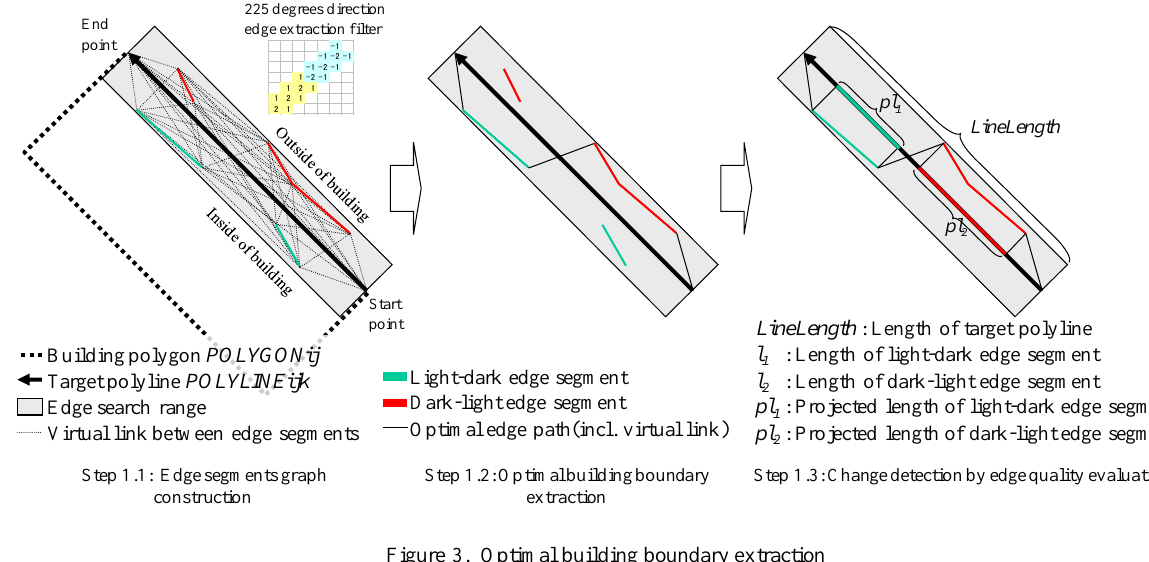
Figure 2. Optimal building boundary extraction algorithm